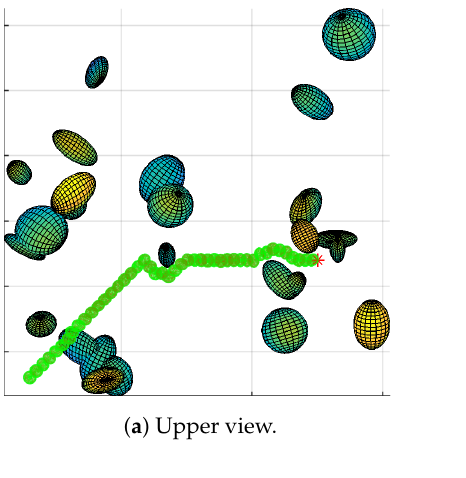
( a ) Upper view. ( b ) Lower view.